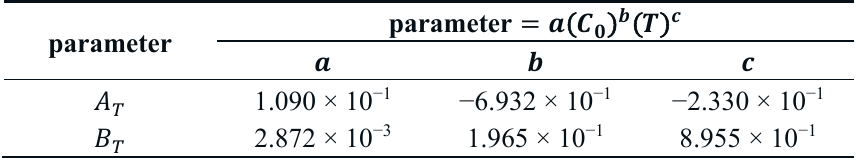
Table 2. Coefficients obtained for bromoform using multivariate regression